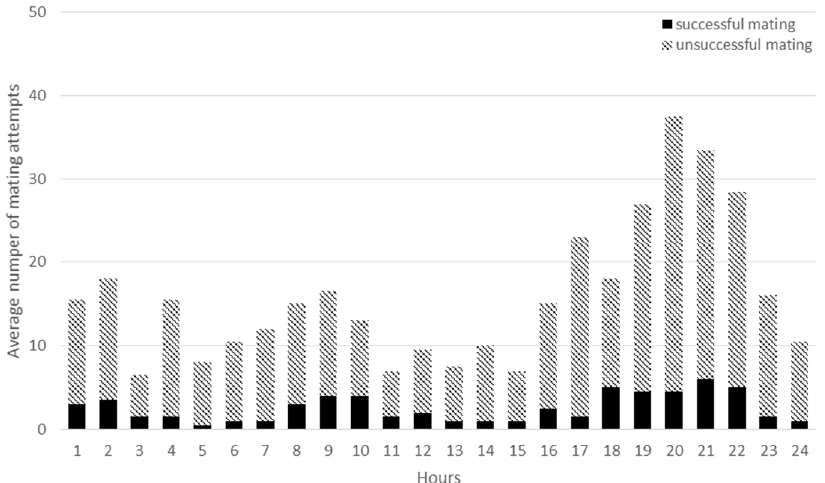
Figure 7. The daily distribution of successful matings (dark column parts) and unsuccessful mating attempts (light column parts) in HOM groups.